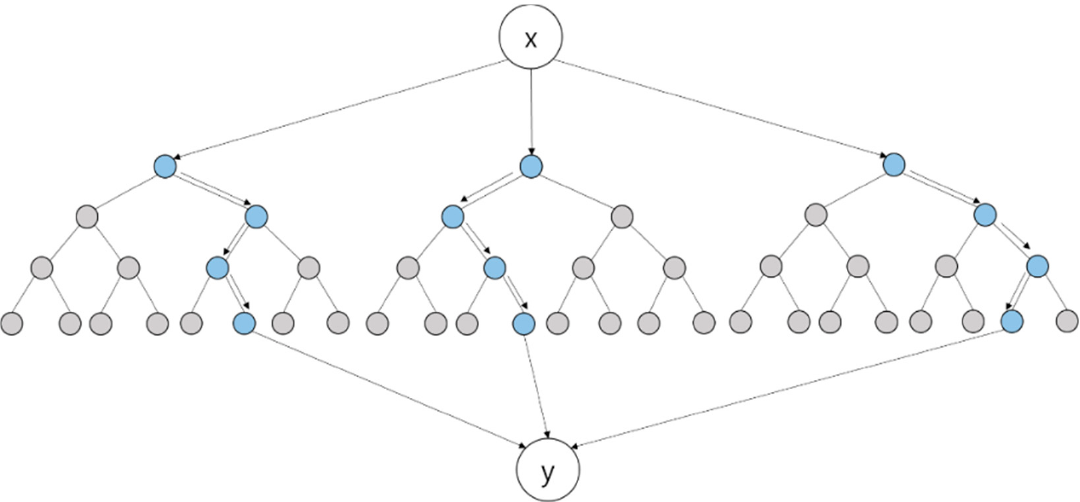
Figure 9. Schematic representation of random forest algorithm.